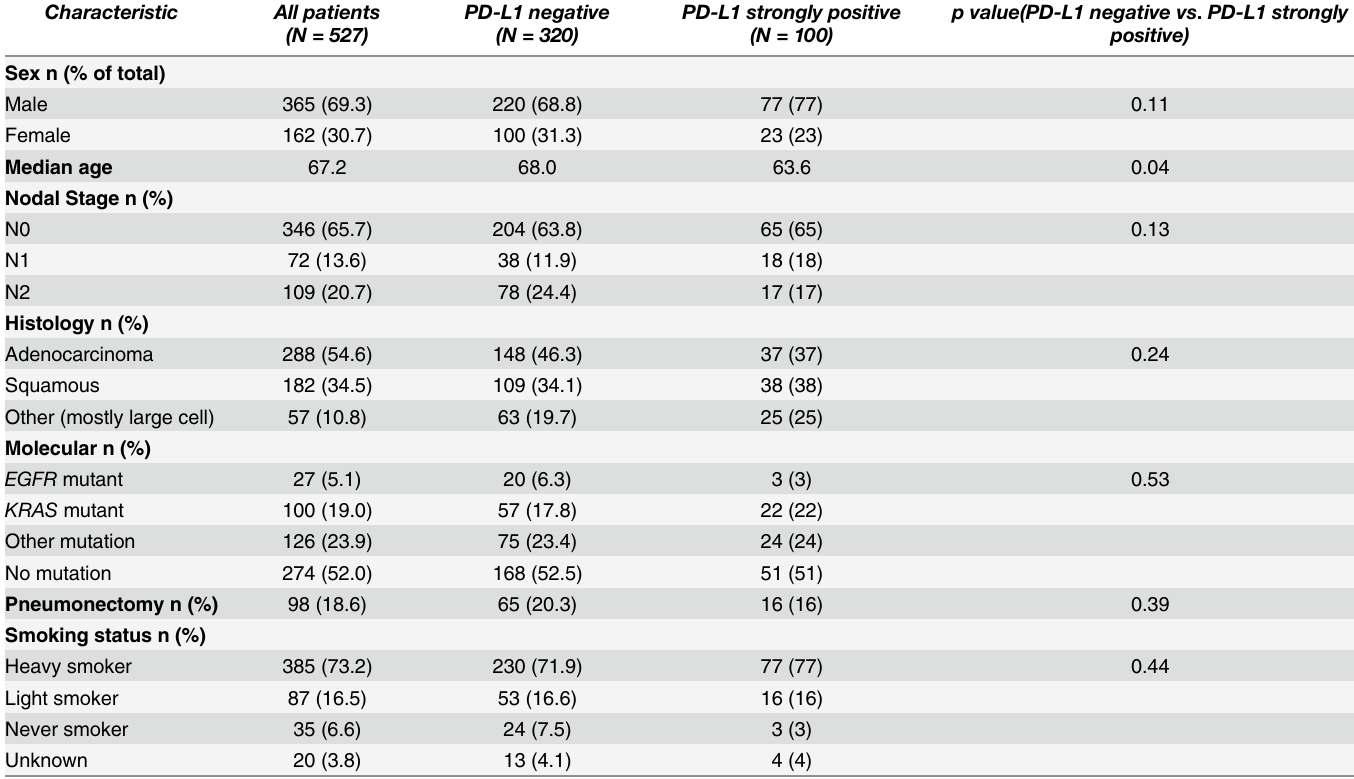
Table 1. Clinico-pathological characteristics of